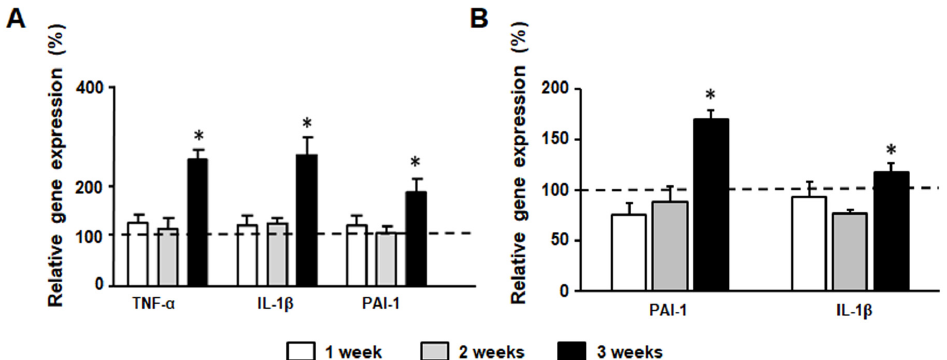
Figure 6. Inflammation marker gene expression. Liver ( A ) and islet ( B ) gene expression. Bar plots represent percentage expression of each gene registered in F rats compared to expression (100%) in their respective controls (C rats) (dashed line). Values are expressed as means ± SEM ( n = 12 rats per group) * p < 0.05 compared to each control at each time point.